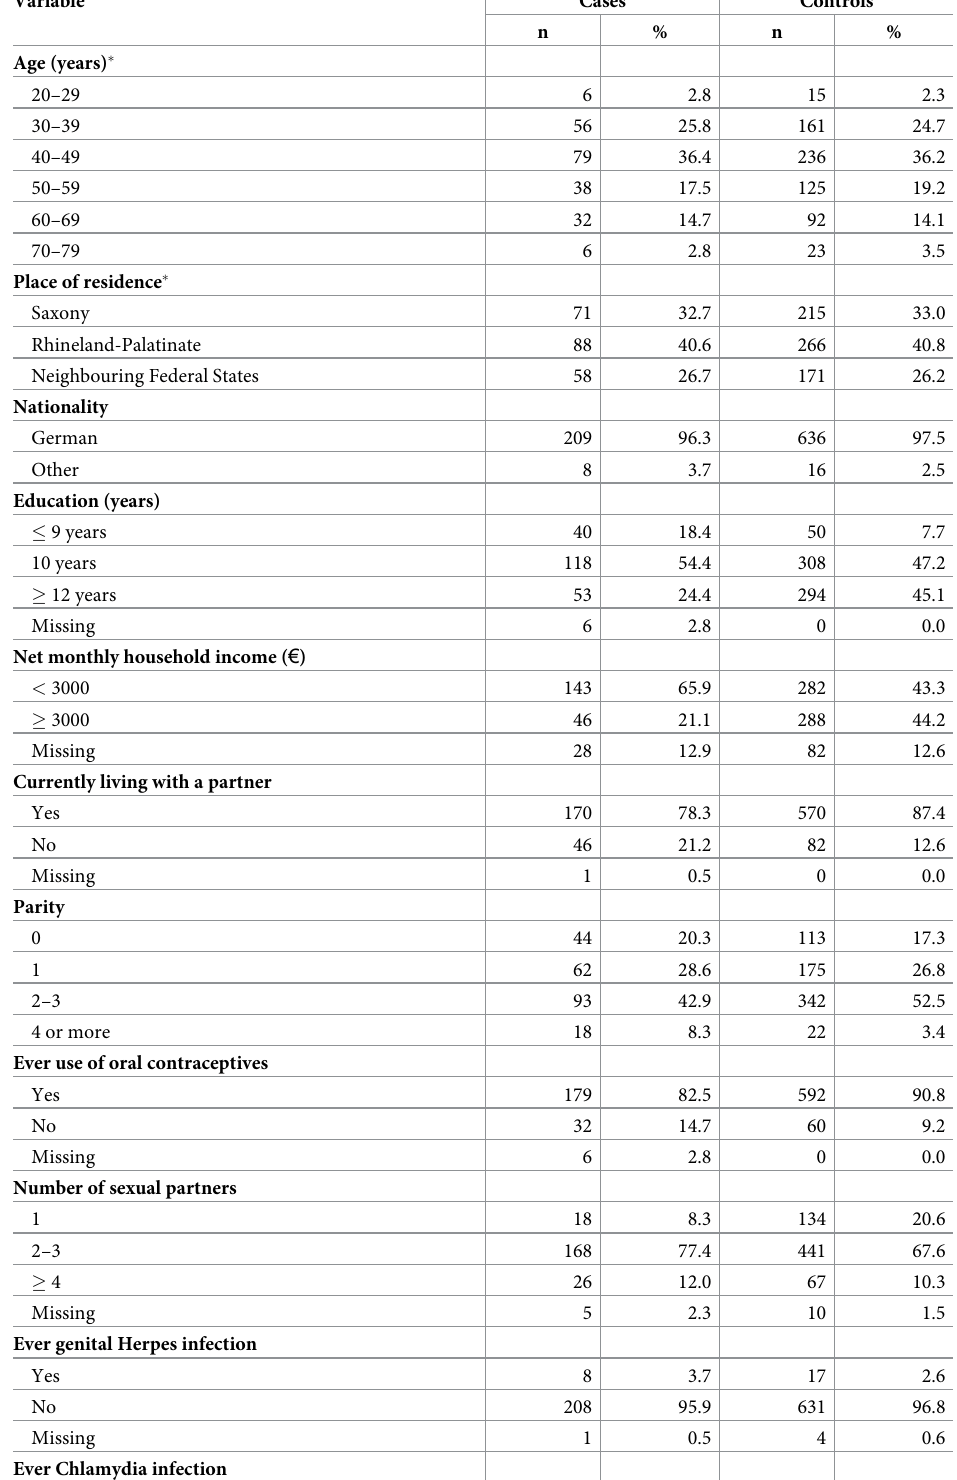
Table 1. Socio-demographic characteristics and risk factors of the study population (217 cases and 652